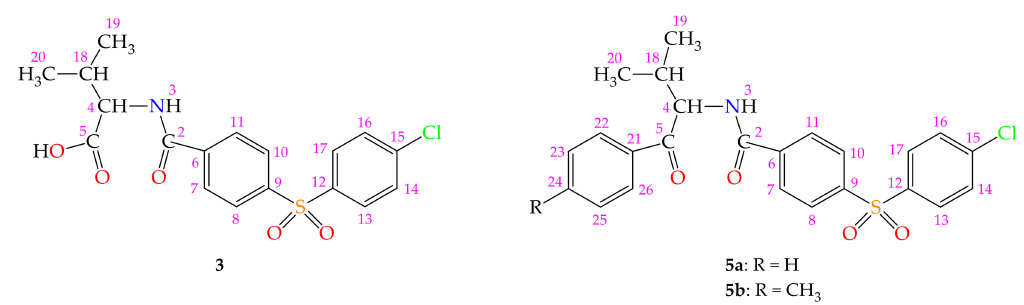
Figure 3. Structures of compounds 3 and 5a , b with the atoms’ numbering (for NMR assignments).